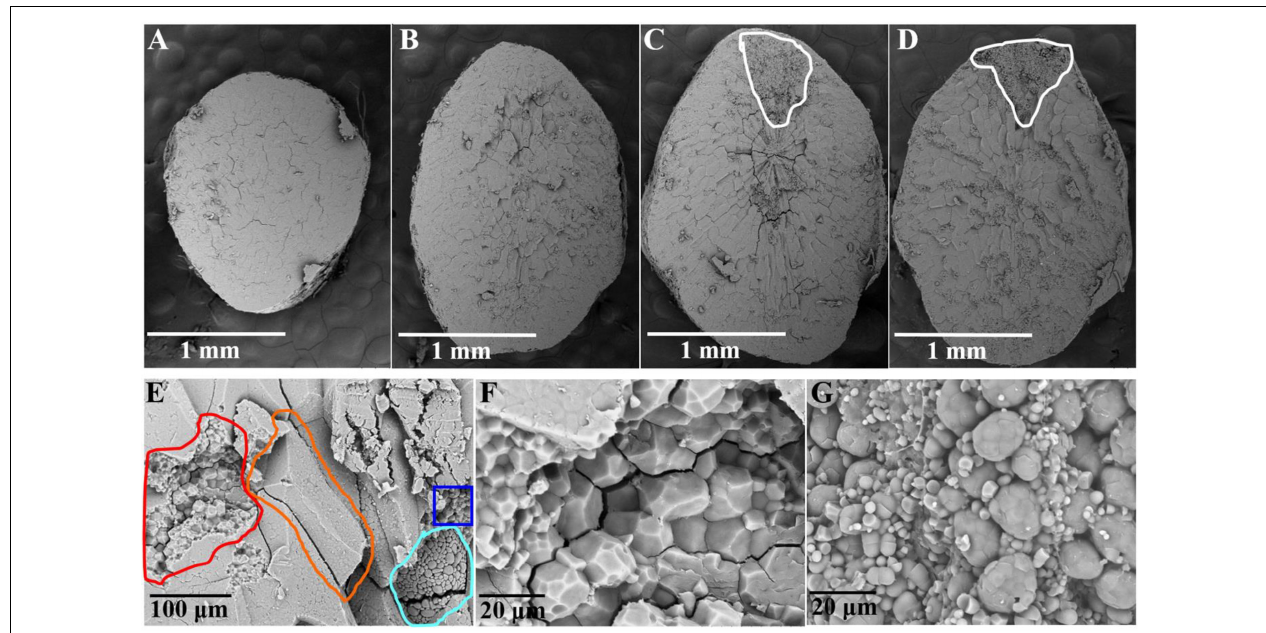
FIGURE 5 | Transverse sections of the rice endosperm observed by SEM. Shown in panels (A–D) are whole transverse sections of a ZJB, NIL qDEC 5 , NIL qdec 5 , and ZB rice grains, respectively, as observed by SEM. The chalky part is located within the white circle (C,D) . Panel (E) is a local cross-section of a ZB rice grain. The orange circle indicates one side of a whole starch cell in the non-chalky part, the red circle indicates the torn cell cross-section in the non-chalky part, the blue circle indicates one side of the whole cell in the chalky part, and the blue-purple circle indicates the torn cell cross-section in the chalky part. (F) Magnified image of some parts of the red circle in panel (E) . (G) Magnified image of some parts of the blue-purple circle in panel (E)